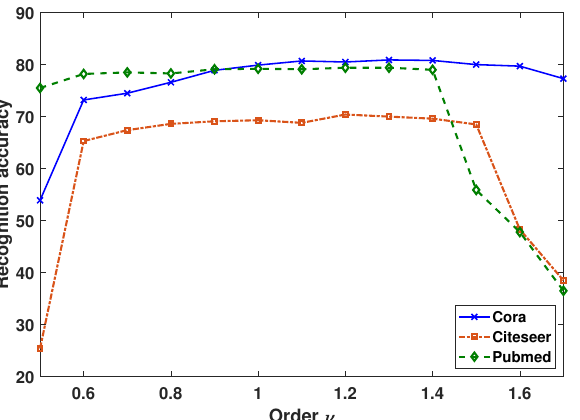
Figure 5. Recognition accuracy (%) of FGNN with different fractional orders ν ∈ [ 0.5,1.7 ] on the citation network datasets.